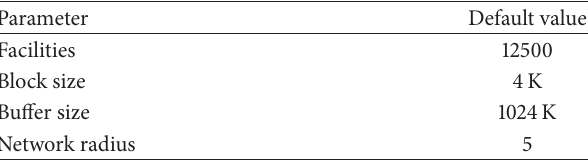
Table 2: The default values of